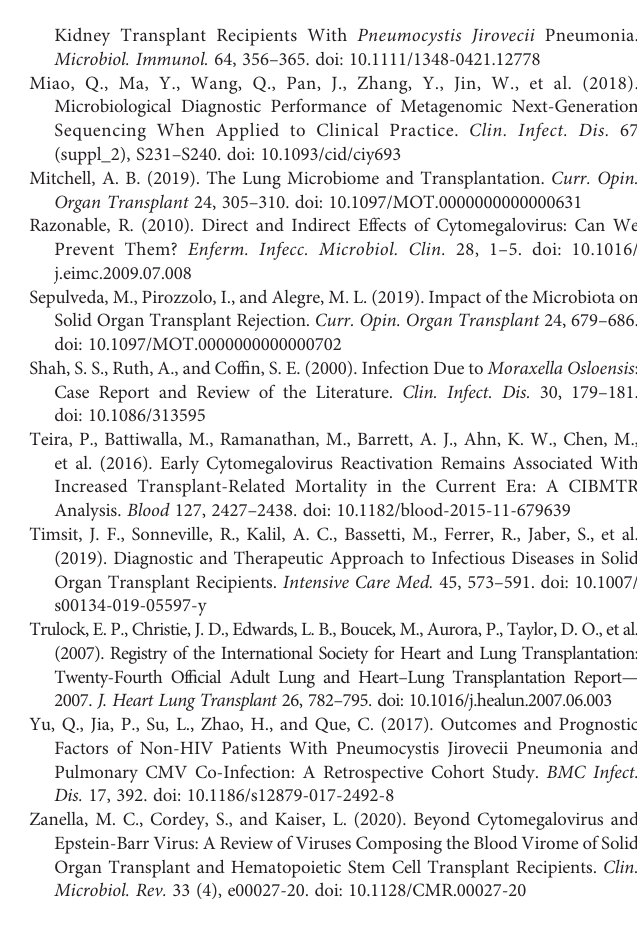
(B) lung microbiomein specieslevel; (C) Estimated speciesrichnesswas calculated as Shannon index, there were no signi fi cant differences; (D) anosim analysis of lung microbiome; (E) nonmetric multidimensional scaling analysis revealed that the within-group variance is larger than the between-group